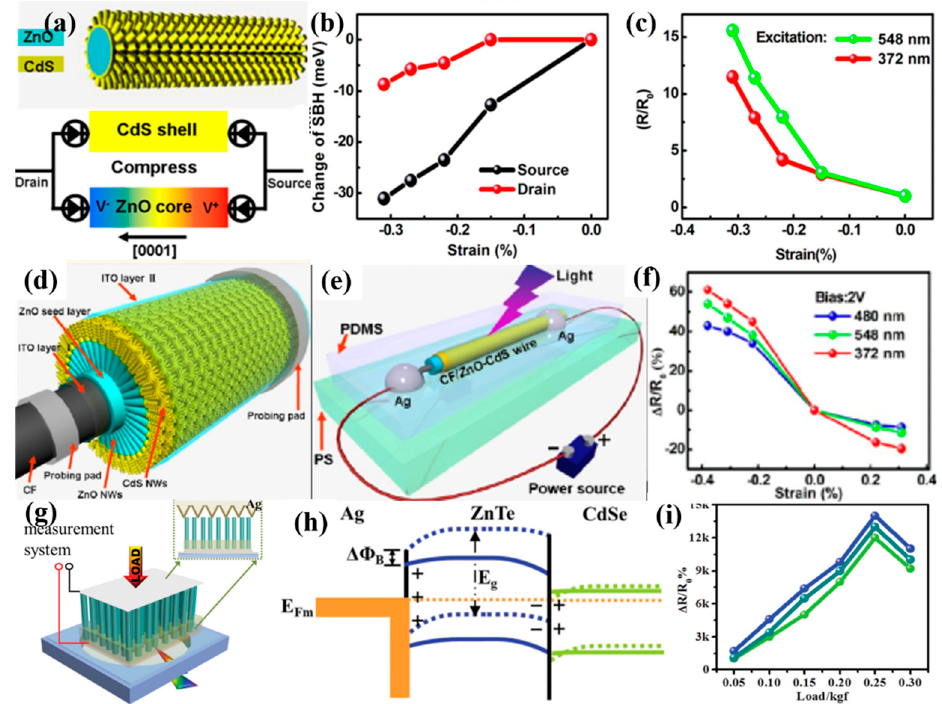
Figure 12. ( a ) Schematic diagram of ZnO / CdS core-shell structure (top), the sandwich model of the PD device, and simulation of the piezopotential distribution in the ZnO nanowire under compressive strain (bottom). ( b ) Relationship between compressive strain and changing Schottky barrier heights. Black curve and red curve represent the SBHs change with strains at source-drain bias of V = 2 and − 2 V, respectively. ( c ) The derived change of responsivity in SBH as a function of compressive strains under illumination of green light (548 nm) and UV light (372 nm); R 0 represents the responsivity of the PD device without compressive strains. ( d ) Schematic representation of CF / ZnO-CdS wire structure. ( e ) Schematic diagram of the PDs based on a single CF / ZnO-CdS wire. ( f ) The strain dependence of ∆ R / R 0 excited by blue light (480 nm), green light (548 nm), and UV light (372 nm); R 0 is the responsivity without strain, and ∆ R was set as the variation of responsivity. ( g ) Schematic diagram of CdSe / ZnTe core / shell nanowire array PDs on PVC with illumination source underneath; the inset is a cross-sectional schematic diagram of the assembled PDs. ( h ) Schematic energy band alignment of the Ag / ZnTe / CdSe structure under compressive load and illumination. ( i ) The strain dependence of ∆ R / R 0 under constant illumination [105,106,114] .